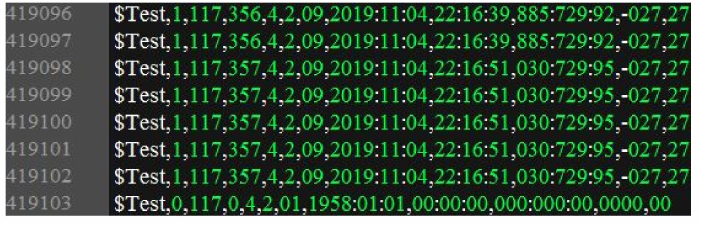
Figure 11. Screenshot of some experimental data.